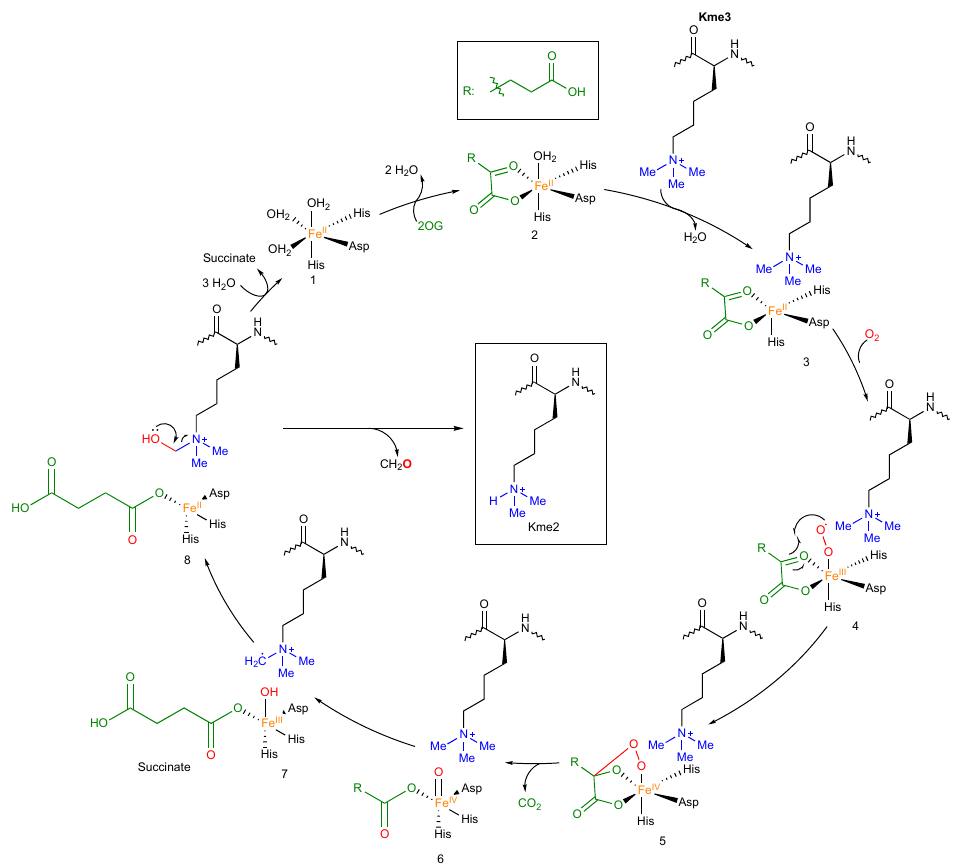
Figure 13. Consensus mechanism for Jumonji histone demethylase (JHDM)-catalyzed demethylation of Kme3. ( 1 ) Bidentate coordination of 2OG to Fe(II) is followed up by ( 2 ) substrate binding and ( 3 ) weakened Fe(II)-water coordination, opening a coordination site for O 2 and subsequent formation of a Fe(III)-superoxide intermediate. ( 4 ) Oxidative decarboxylation by the distal oxide results in the formation of a bicyclic intermediate and an Fe(IV)–oxo intermediate before ( 5 ) CO 2 is released from the active site. ( 6 ) Fe(IV)–oxo reacts with the substrate C–H to yield an Fe(III)–OH. ( 7 ) A radical substrate removes the hydroxyl from the Fe(III)–OH complex ( 8 ) before being dispelled from the active site, resetting it back to its original state.